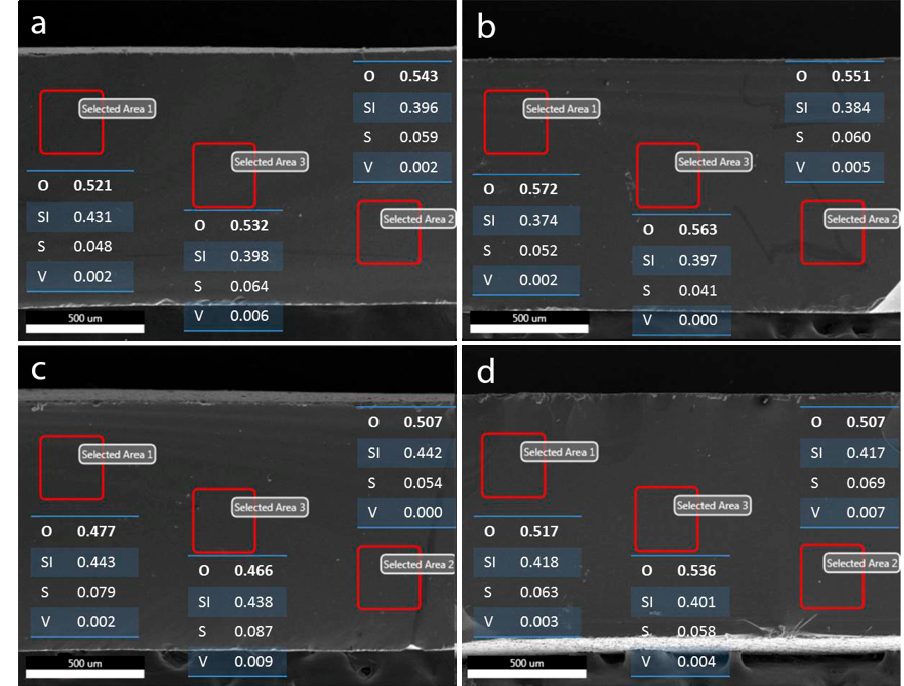
Figure 5. Results of elemental survey by EDS point analysis at various depths of the VPG membrane after being equilibrated in different vanadium ion solutions: ( a ) V 2+ , ( b ) V 3+ , ( c ) VO 2+ , and ( d ) VO 2+ solution in 2 M H 2 SO 4 , respectively.